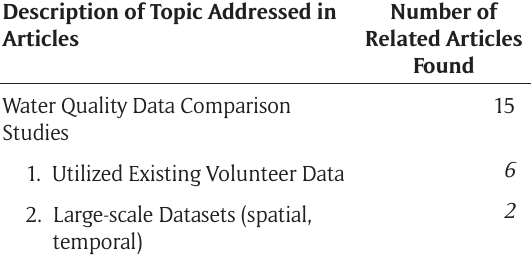
Table 1: Water Quality Data Comparison Studies. Breakdown of type and number of studies found (n =